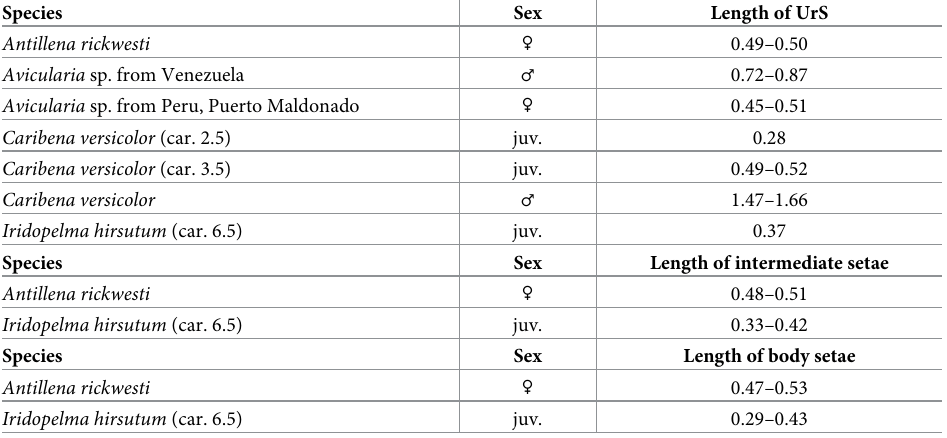
Table 9. Length ranges of type II setae, body setae and setae of intermediate morphology. juv. = juvenile specimen. car. = length of